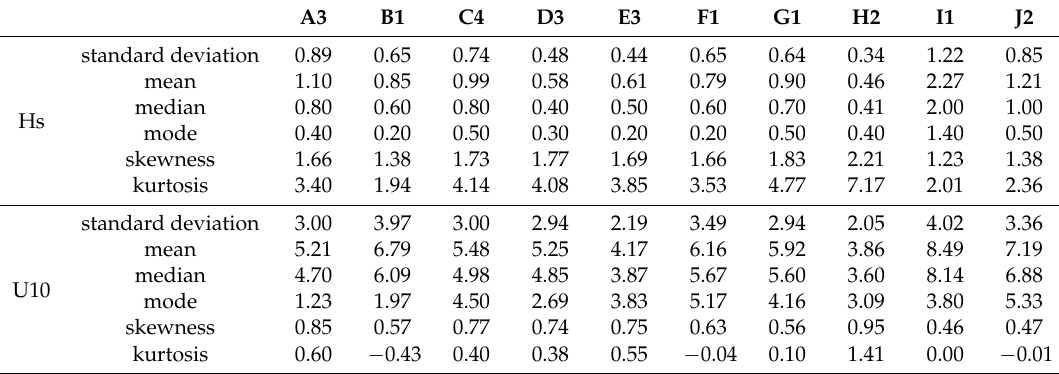
Table 6. Hs and U10 statistics of the most representative points. The results are available for the 35-year time interval 1983–2017.